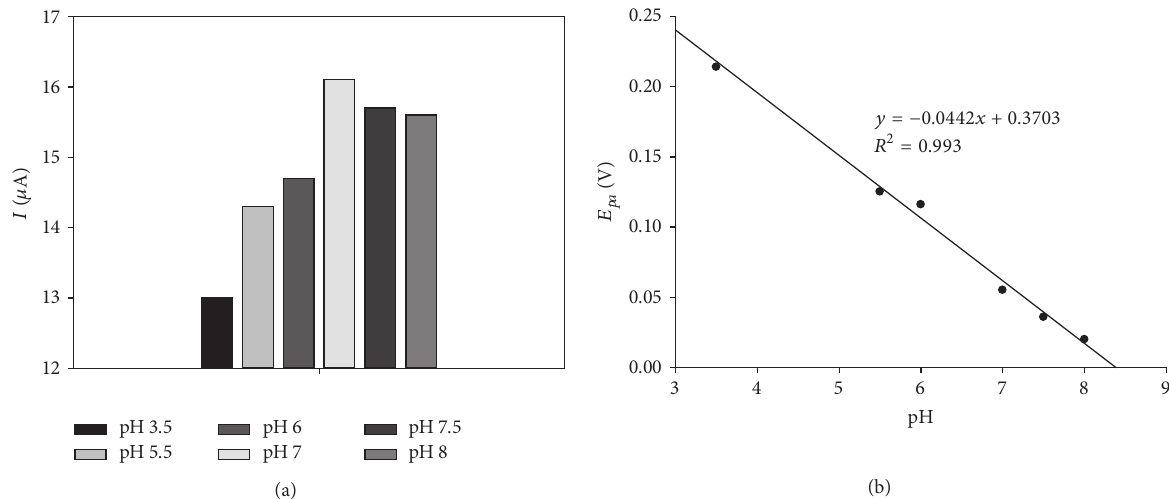
Figure 2: The effect of pH on the redox peak currents of NAF-MWCNTs-COOH-GCE-CAT in various buffer solutions with pH values 3.5, 5.5, 6.0, 7.0, 7.5, and 8.0 (a); 𝐸 𝑝𝑎 versus pH plot (b).